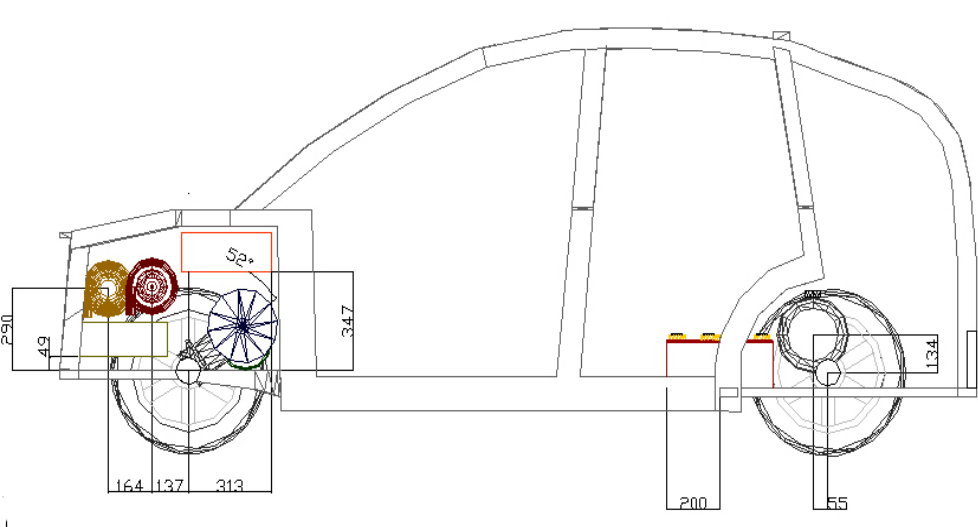
Figure 12. Views and main dimensions (in mm) of the LETHE © Sedan